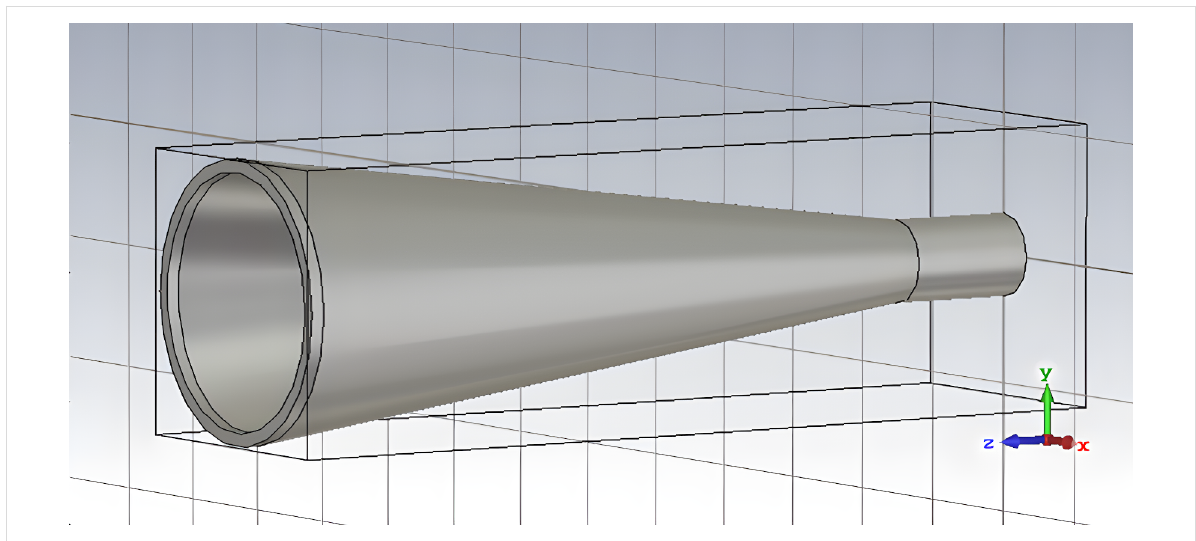
Figure 1: The front part and the constriction of the back-to-back horn of the LSPE-SWIPE receiving system [3] used for the calculation of the mode composition in the constriction.